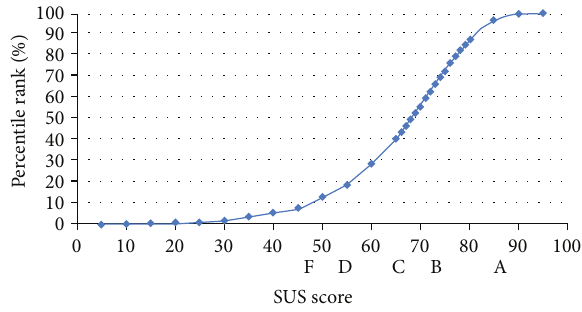
Figure 2: Association between percentile ranks, SUS scores, and letter grades